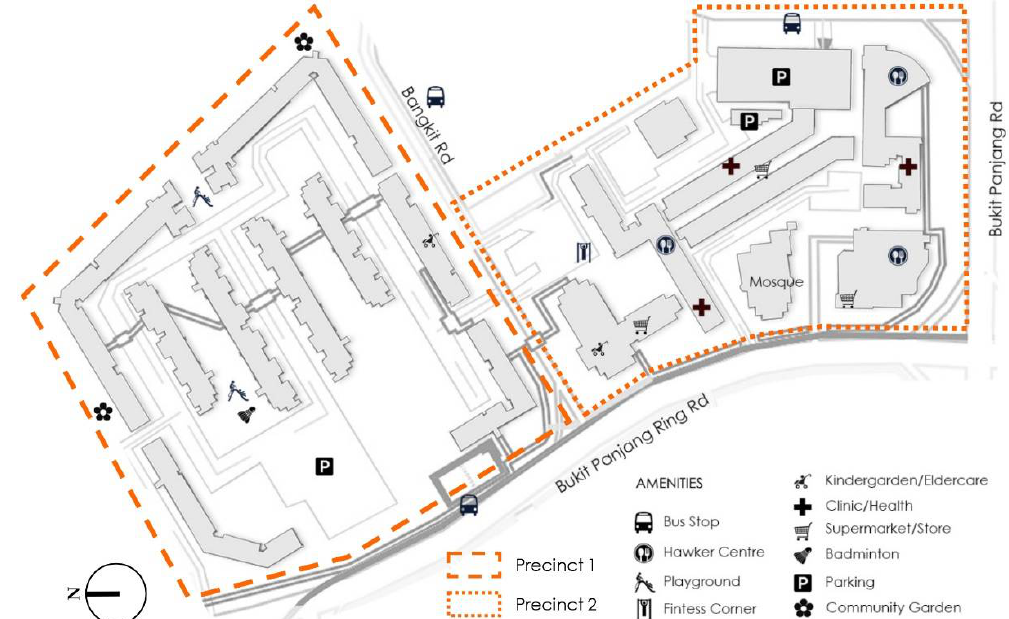
Figure 2. Neighbourhood 1: Bankgit, Bukit Panjang—spatial layout and amenities (source: by author).